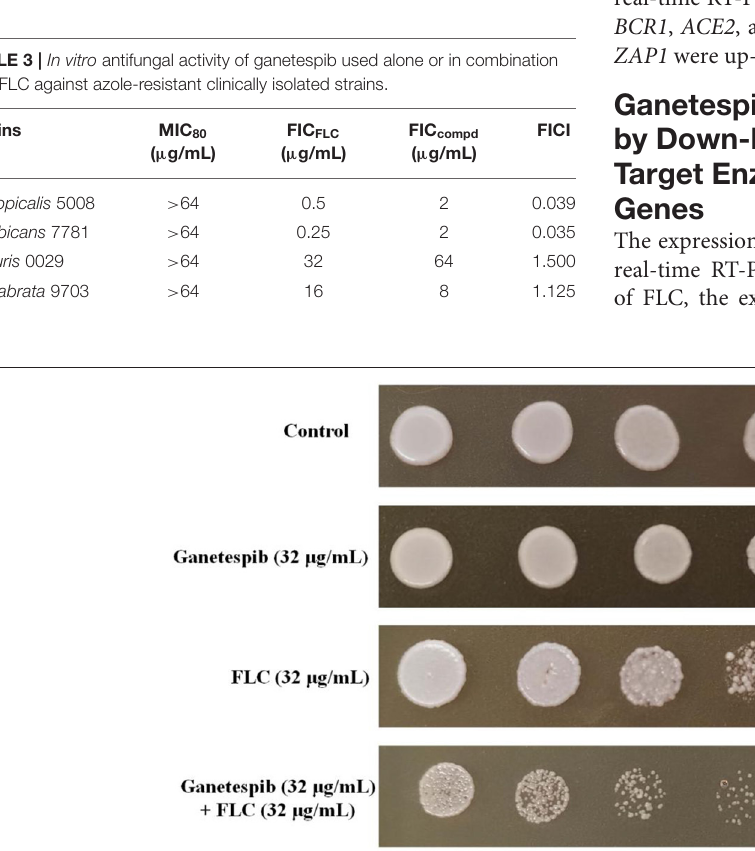
Frontiers in Microbiology |